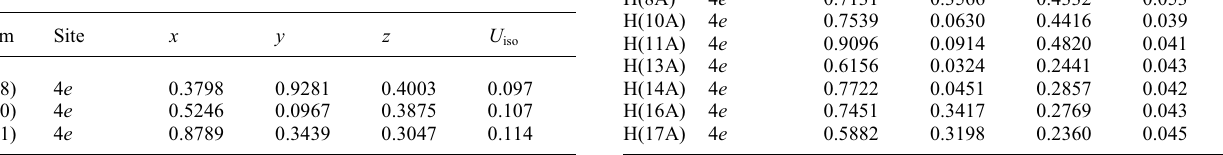
Table 2. Atomic coordinates and displacement parameters (in Å 2 ) .